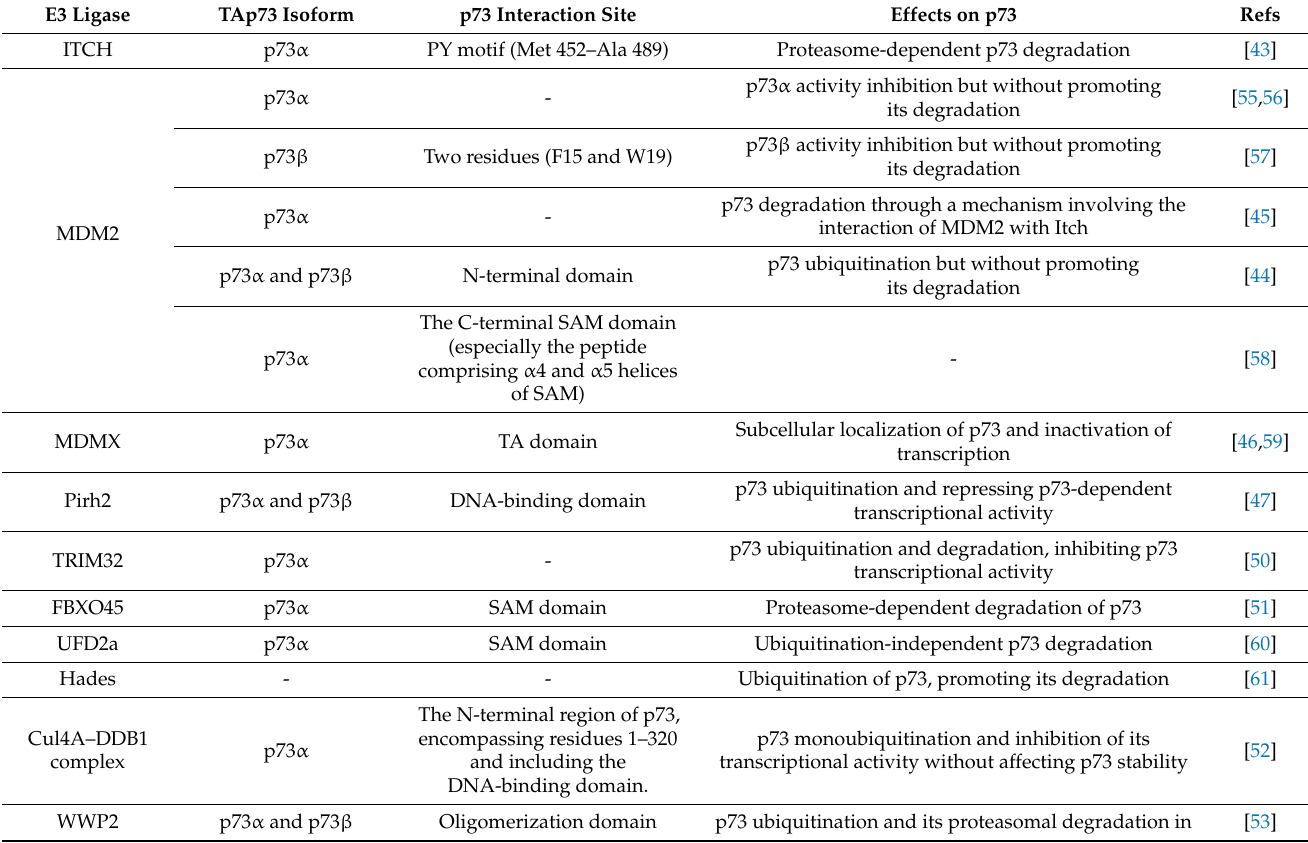
Table 1. Role of E3 ligases in p73 stability. TRIM32: tripartite motif 32; Cul4A: Cullin4A; MDM2: mouse double minute 2 homolog; Pirh2: p53-induced RING-H2